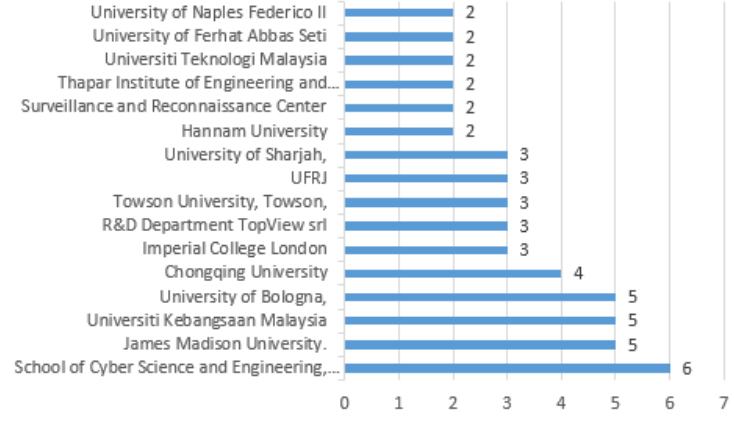
Figure 7. Distribution by institutions of the